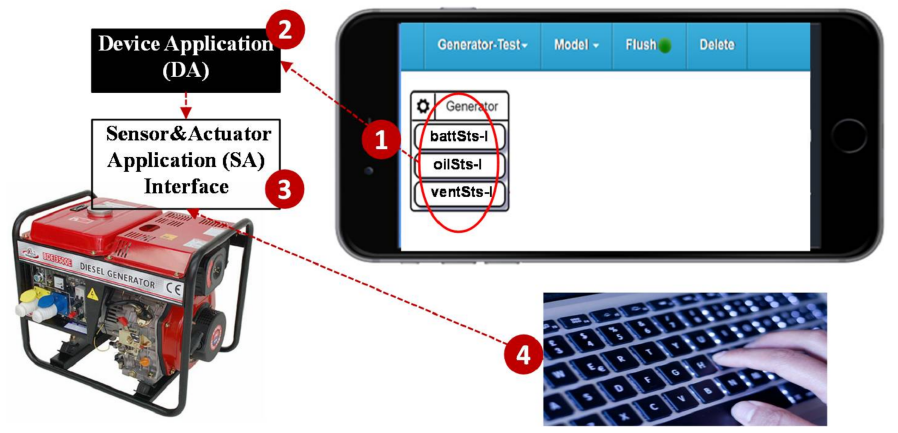
Figure 7. Automatic generation of the codes for the DA and the SA